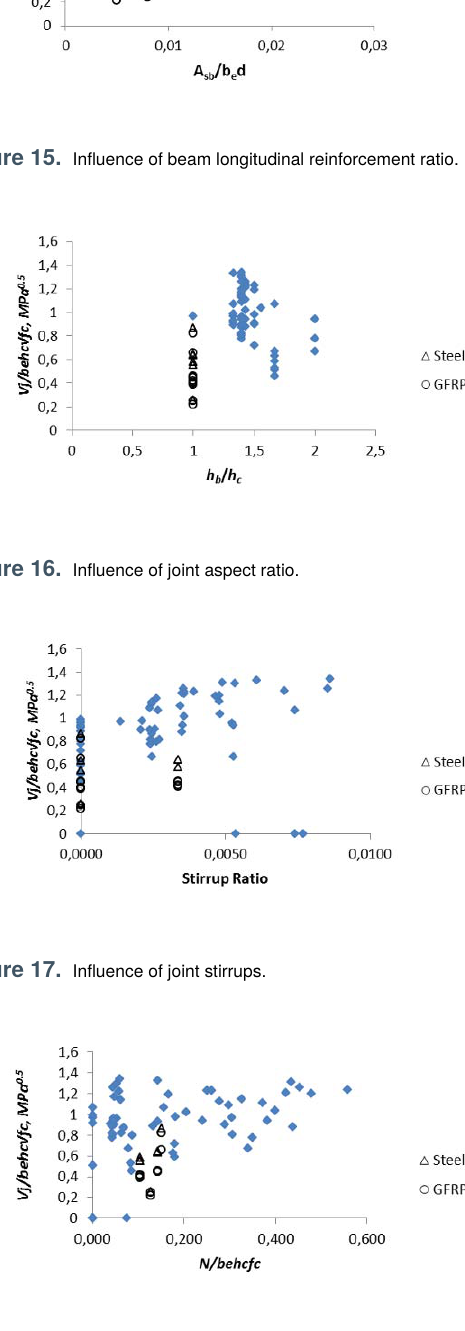
Figure 18. Influence of column axial